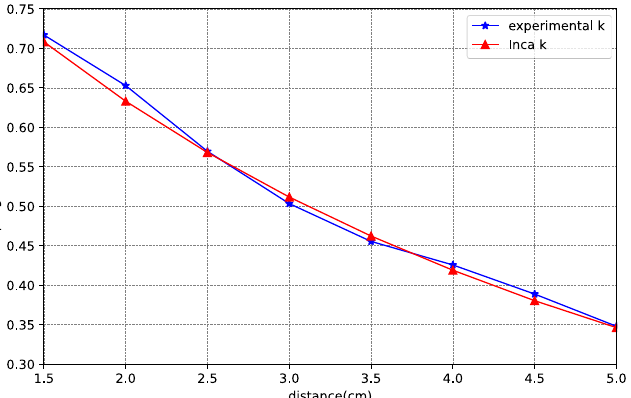
Figure 16. Comparison between the estimated value of coupling coefficient k and Inca value at different transmission distances.